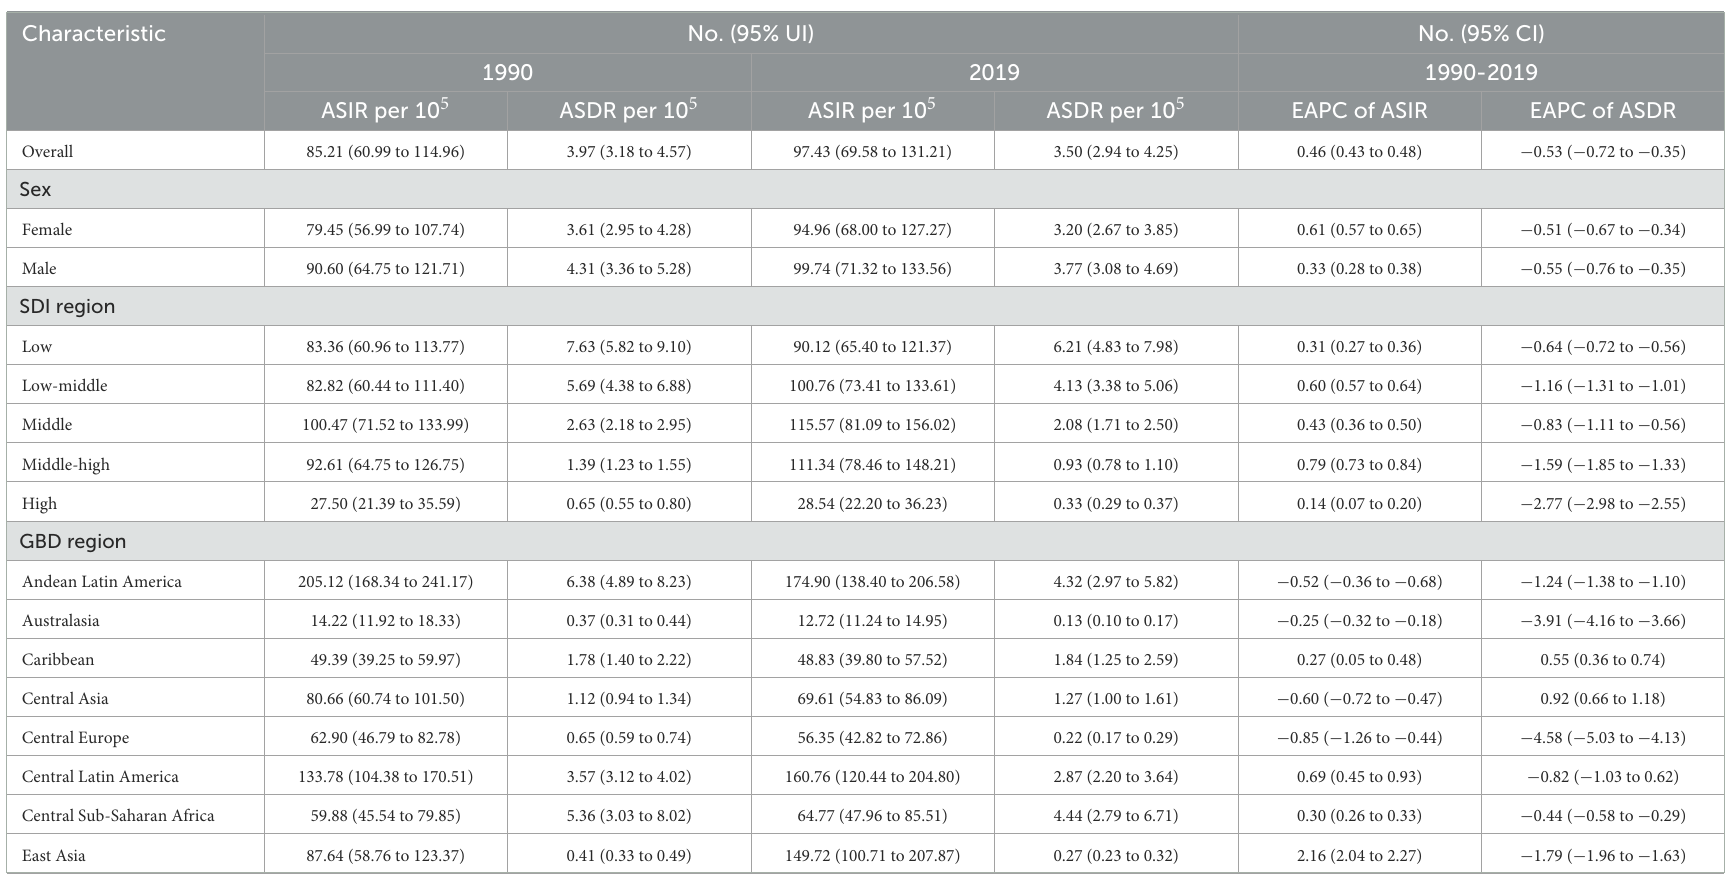
TABLE 2 ASIRs and ASDRs of NSNIs in 1990 and 2019 and their change trends from 1990 to 2019.